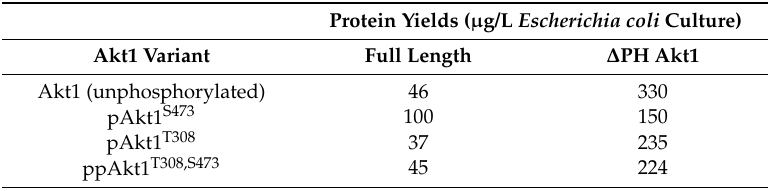
Table 1. Protein yields for Akt1